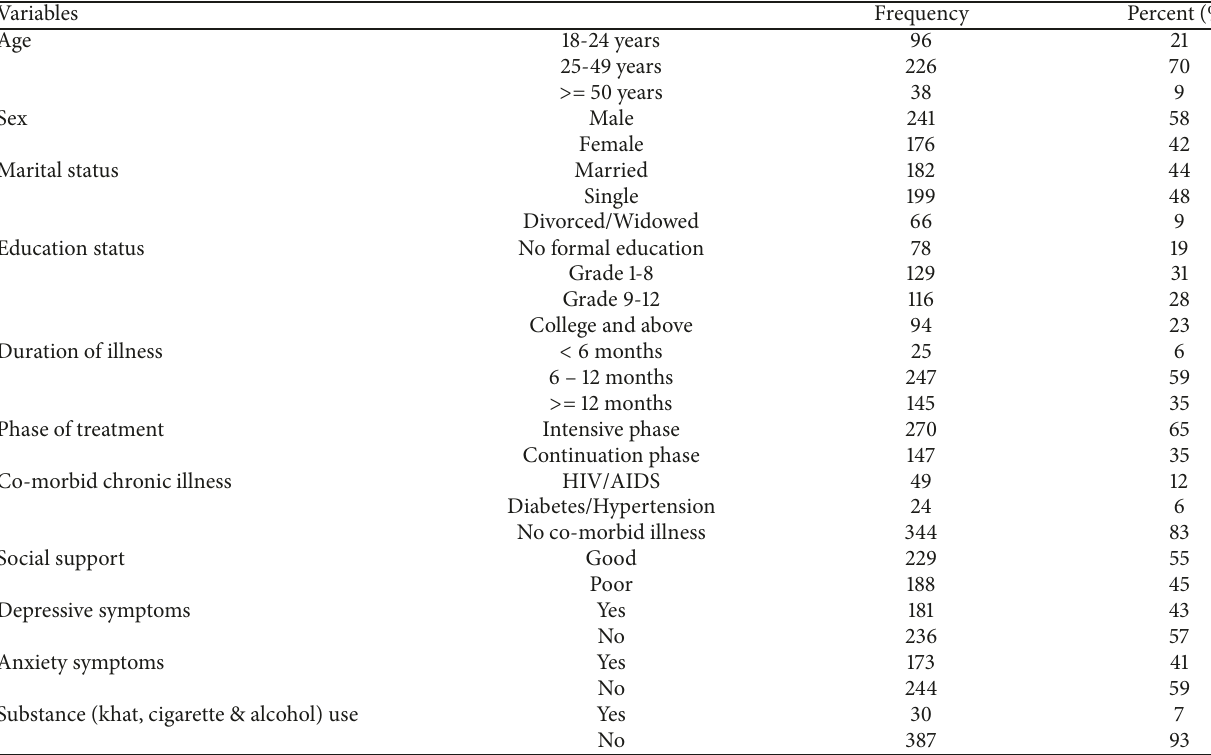
Table 1: Sociodemographic and clinical characteristics of TB patients on follow-up at Wolaita Sodo University Hospital, Wolaita Sodo, Ethiopia, 2016 .